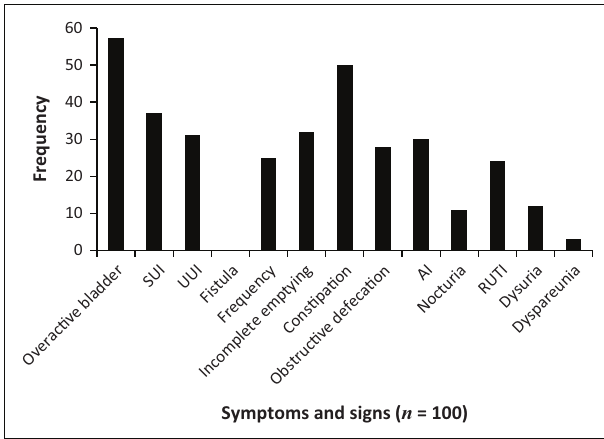
AI, anal incontinence; RUTI, recurrent urinary tract infections; SUI, stress urinary incontinence; UUI, urge urinary incontinence. FIGURE 1: Symptoms and